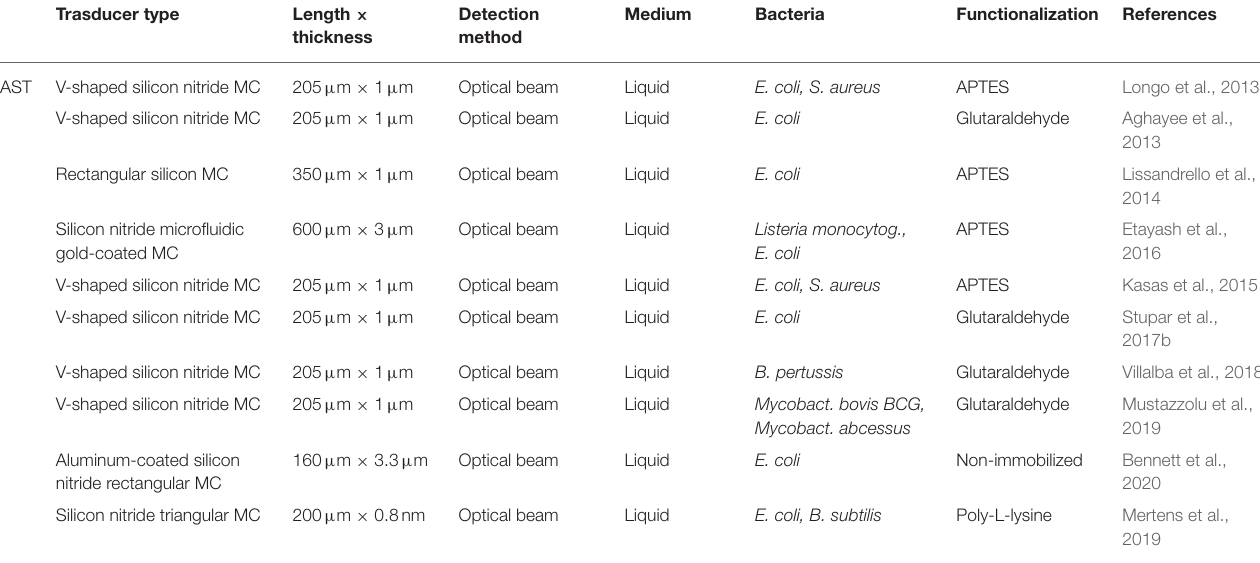
TABLE 2 | Main features of nanomechanical sensors for